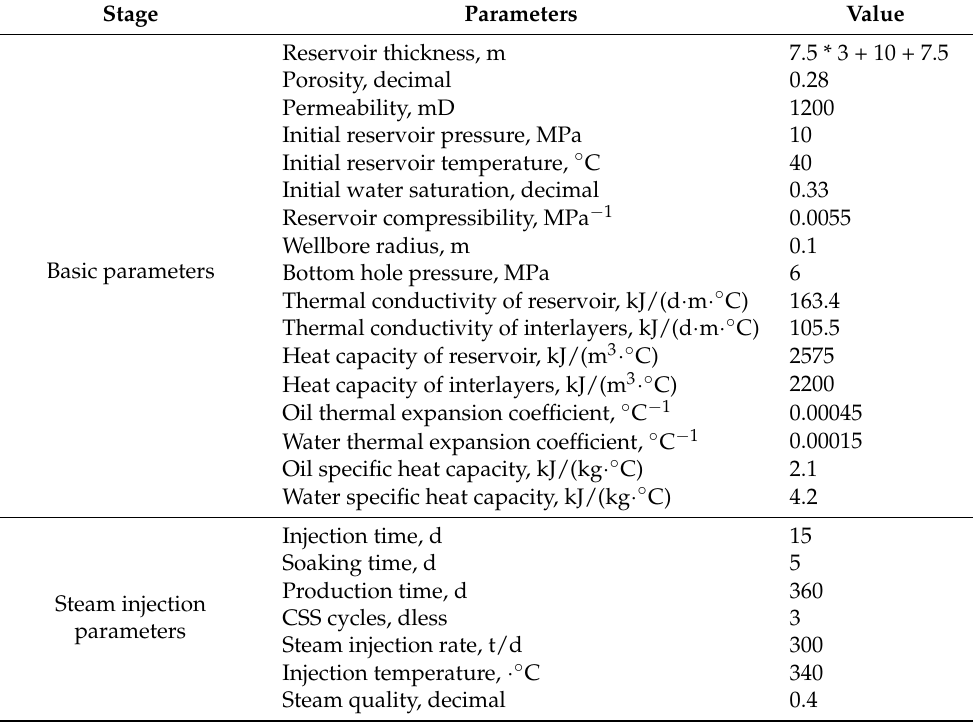
Table 1. The basic parameters used in this